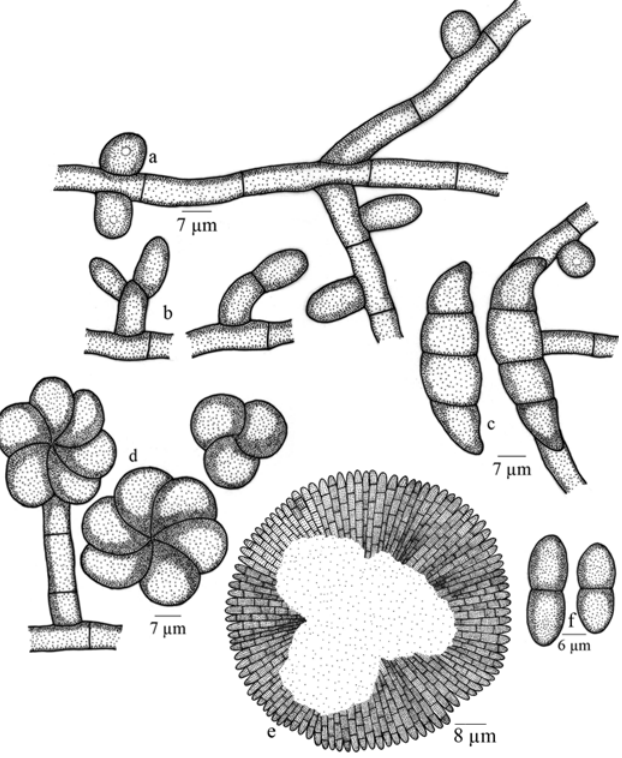
Figure 1. Schiffnerula canthii sp. nov. a - Appressorium; b - Conidiophore; c - Conidia of Questieriella